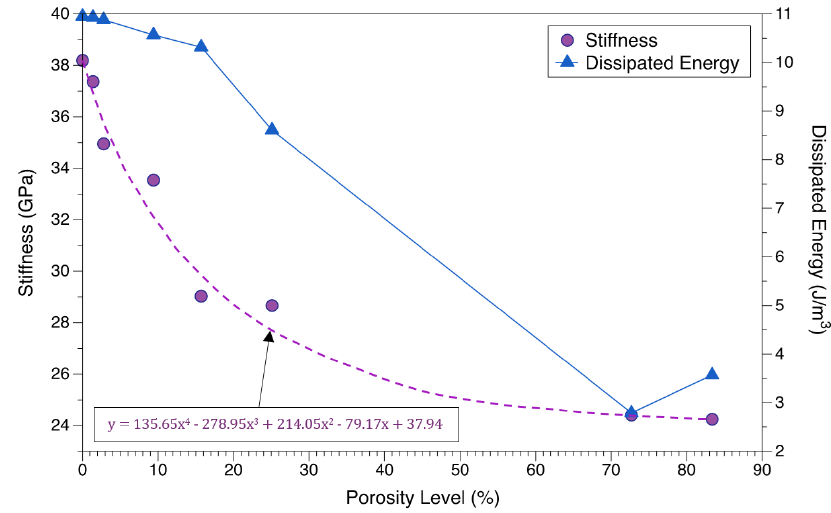
Figure 17. Variation of stiffness and energy dissipated per unit volume per cycle, with the increasing levels of porosity.